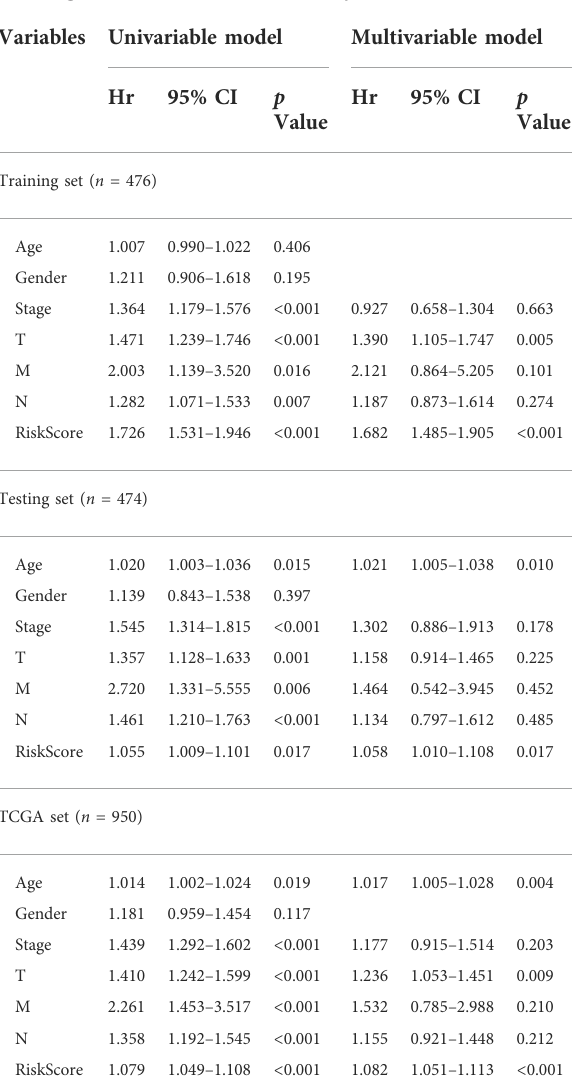
TABLE 3 Univariate and Multivariate Cox regression analysis of the GIrLncSig and overall survival in different patient